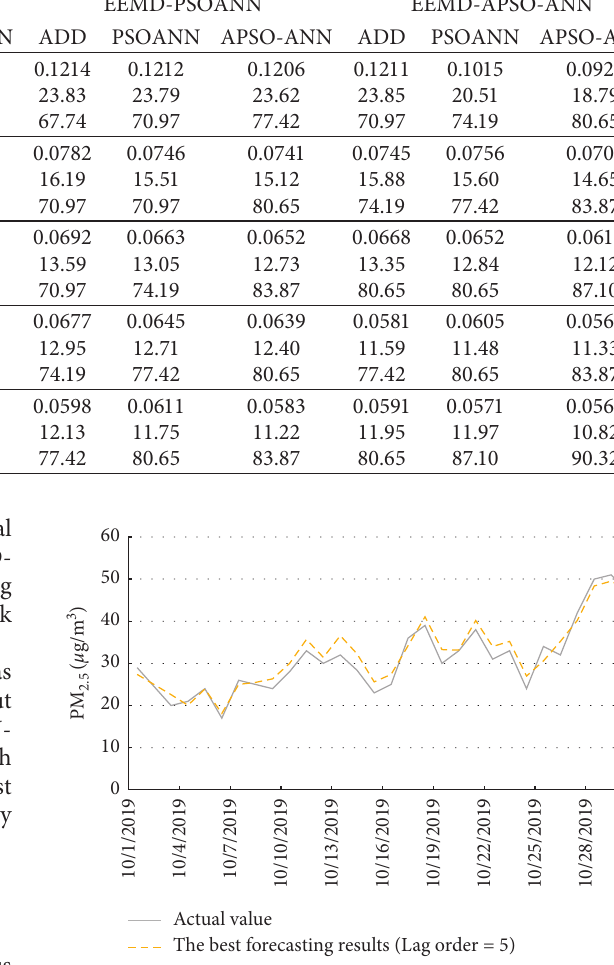
Figure 4: The best forecasting results of PM Lanzhou city in